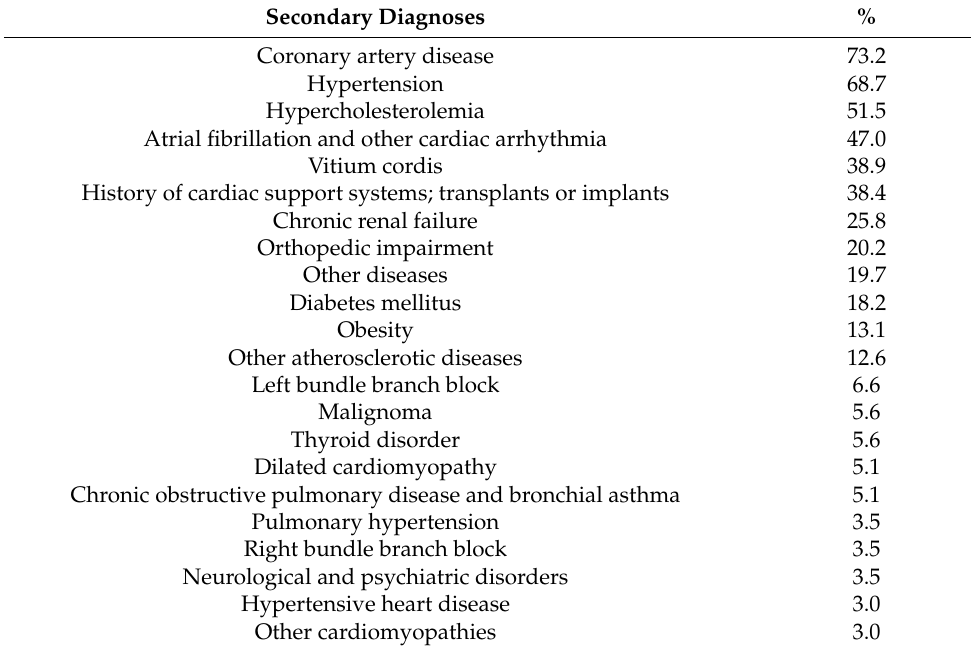
Table 2. Overview of diagnoses as relative values in percent.